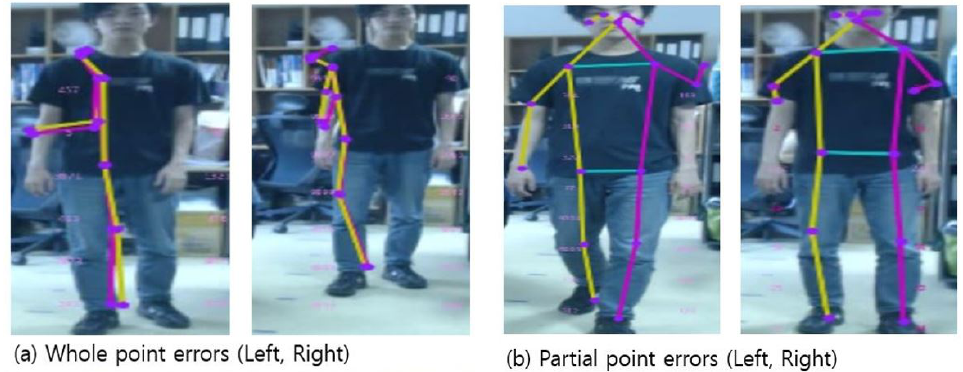
Figure 3. Detection errors can be divided into two types. ( a ): Whole point error is an error in which all point coordinates are wrong. All joint points of the target in ( a ) are detected in the wrong place. ( b ): Partial point error is an error in which the coordinates of a single point or a couple of points are wrong. The wrist point of the target in ( b ) is detected in the wrong place, while the other joint points are detected at a tolerable